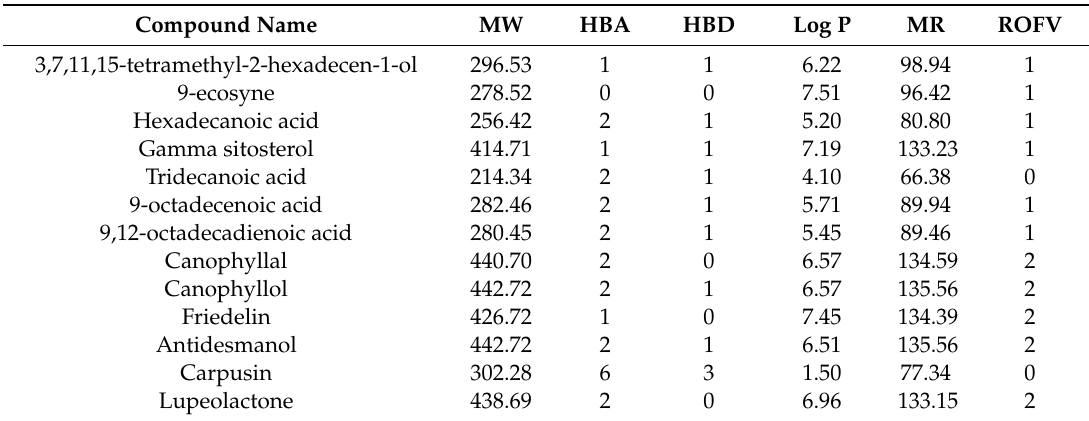
Table 7. ADME / T (Absorption, distribution, metabolism, excretion, and toxicity) properties prediction of the bioactive compounds by SwissADME.